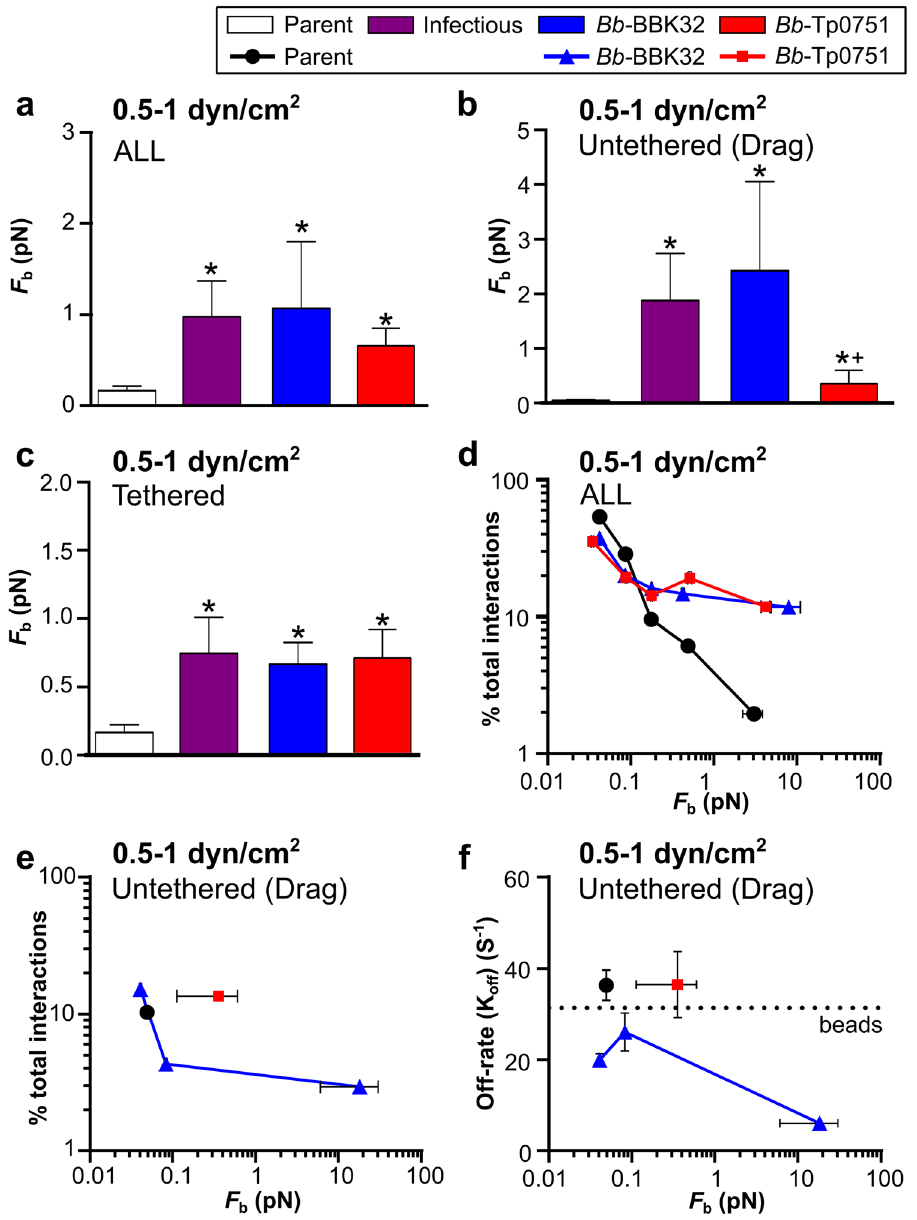
Figure 4. Bond strengths of Tp0751-dependent interactions under shear stress. Forces imposed on individual load-bearing adhesion bonds ( F b ) for bacterial-endothelial interactions tracked at 0.5 and 1 dyn/cm 2 were estimated as described in the Materials and Methods. ( a – c ) Bond forces for all ( a ), untethered ( b ) and tethered ( c ) interactions (mean ± 95% CI). ( d , e ) Percentages of tracked interactions for each strain occurring at indicated F b values. Percentages for both tethered and untethered interactions combined are shown in ( d ), and untethered interactions alone are shown in ( e ). F b values for all interactions combined were binned by force range to obtain Mean ± SEM F b values plotted on x-axes. For untethered interactions, interactions were grouped by F b into a smaller number of bins than for all interactions combined ( e ), to provide sufficient interaction numbers in each bin for accurate calculation of bond dissociation rates at each bond force ( f ). For the parent strain and Bb -Tp0751, fewer than 25 interactions were obtained in all but the lowest force bin. For these strains, the data from the higher force bins were therefore pooled with values from the lowest force bin to obtain sufficient interaction numbers for dissociation rate calculations. This resulted in a single data point reflecting the values obtained for all untethered interactions for parent and Bb -Tp0751 strains. ( f ) Effect of increasing bond force on mean ± SEM bond dissociation rates. Dotted line indicates the dissociation rate for negative control beads. Strains: Negative control strain: BBK32- deficient non-infectious adhesion-attenuated B31-A-derived strain (Parent; GCB706: Supplementary Table S1). Positive control strains: Parent expressing B . burgdorferi vascular adhesin BBK32 ( Bb -BBK32); BBK32-expressing B31-derived infectious strain (Infectious; GCB726: Supplementary Table S1). Bb -Tp0751: Parent expressing Tp0751. Numbers of interactions analyzed/strain: ≥ 288 ( a , d ); ≥ 39 ( b , e , f ); ≥ 249 ( c ). Statistics: one-way Kruskal- Wallis ANOVA with Dunn’s post-tests. * Indicates p < 0.05 vs parent. + Indicates p < 0.05 vs